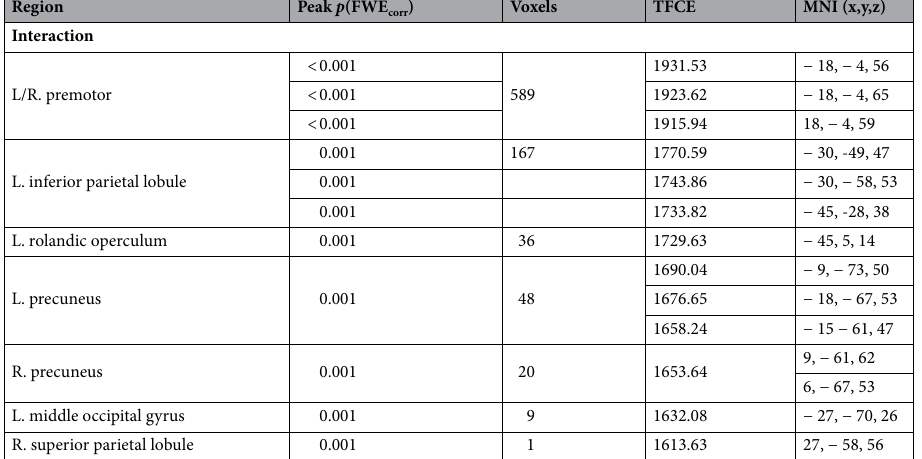
Fig. 1—top row Difference ). A paired comparison for the placebo group yielded no significant change (Fig. 1— bottom row Difference ). Finally, an independent samples t -test at baseline, yields no significant group differences. Estimates of effect size of the PPI Learning contrast. Contrast estimates for the PPI Learning contrast in the escitalopram group show a gradual decrease in intensity associated with the Sequence Learn- ing condition over time. Specifically, results show a linear pattern of decrease in the PPI Learning contrast for the sequence motor Learning condition from baseline to steady state in each motor region resulting from our group × time interaction analysis. Contrast estimates for the placebo group indicate an increase in thalamo- cortico connectivity from baseline to steady state, however, these changes were not significant in post-hoc paired comparisons within the placebo group (Fig. 2). Associations between thalamo‑cortico connectivity changes and escitalopram kinetics. Con- sideration of plasma escitalopram levels at baseline and at steady state yielded a significant negative correlation between the PPI Learning contrast and escitalopram plasma levels, with higher plasma escitalopram levels being associated with greater decreases in connectivity (Table 4). Extraction of the PPI Learning contrast estimates showed that higher plasma escitalopram levels are significantly associated with a lower PPI connectivity between the thalamus and the right superior frontal gyrus, the left SMA, the right M1, and the right superior parietal lobule (Fig. 3). Use of delta images (subtracting the PPI Learning contrast at steady state from baseline) yield a significant correlation between PPI connectivity change and steady state plasma escitalopram levels in bilateral cortical and subcortical regions (Supplemental Table 2; Supplemental Fig S1). Identification of high and low connectivity profiles within the escitalopram group, for each region observed in the correlation analysis, shows a significant interaction between baseline PPI connectivity and peripheral plasma escitalopram levels. This interaction shows that high baseline PPI connectivity is associated with a greater decrease at steady state (Fig. 3, Supplemental Tables 3–6). Associations between thalamo‑cortico connectivity changes and behavioural outcome. Cor- relation analyses investigating a potential relationship between the PPI Learning contrast and mean sequence- specific behavioral outcomes do not yield a significant group difference when comparing escitalopram to pla- cebo.